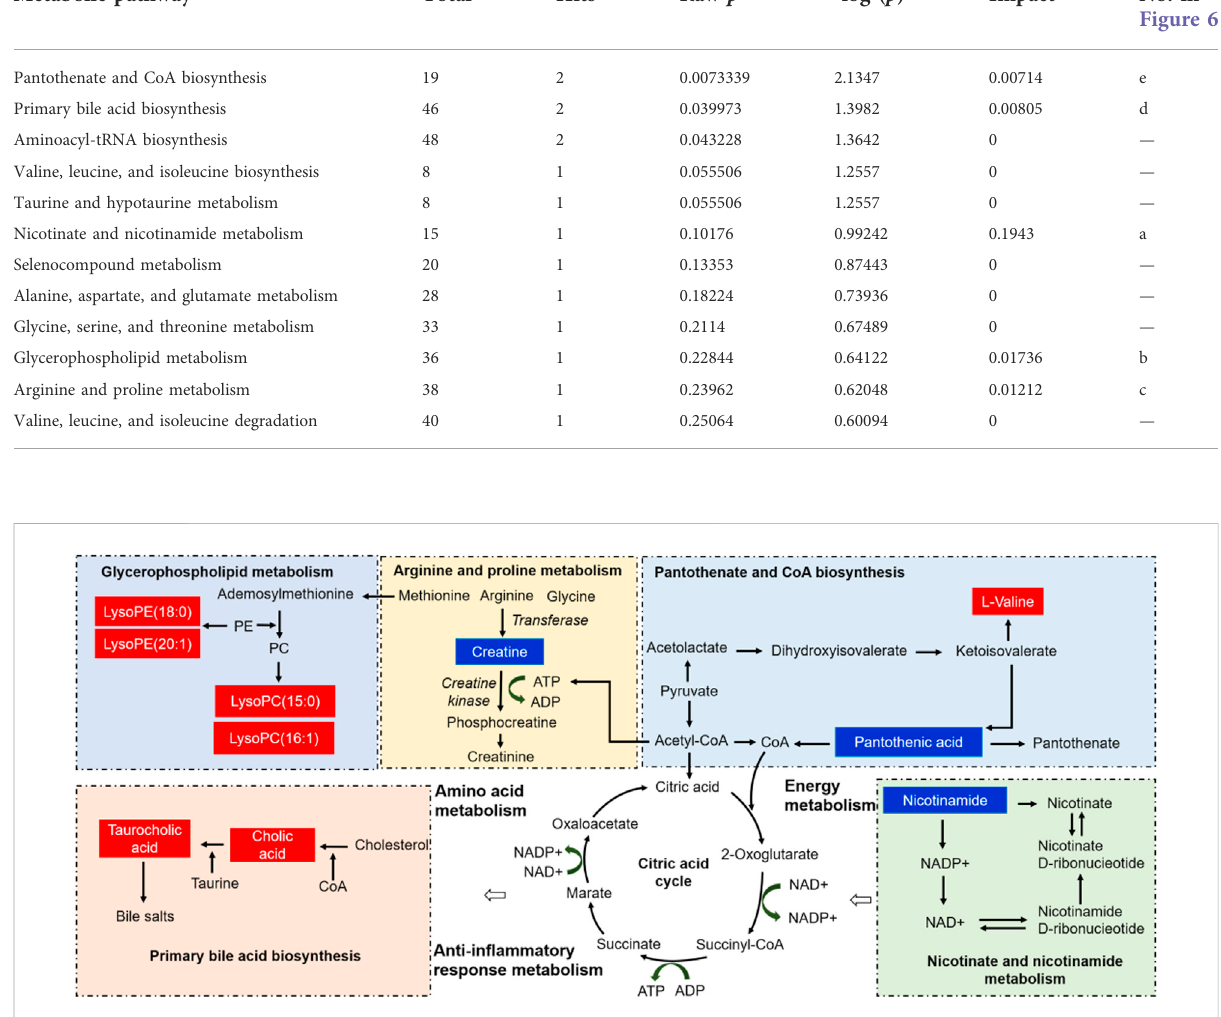
Correlation pathway networks of treatment with LZF solution in TNBS-induced UC. The red and blue represent the metabolites increased and decreased, respectively, compared with the model group. (PC: phosphatidylcholine, PE: phosphatidylethanolamine, LysoPC: lysophosphatidylcholine, LysoPE: